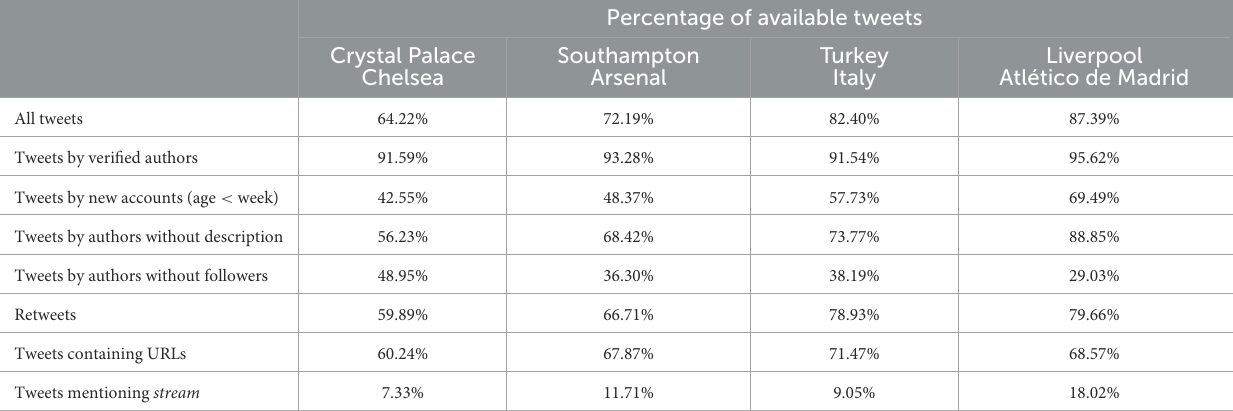
TABLE 5 The percentage of available tweets calculated for selected groups with particular attributes.